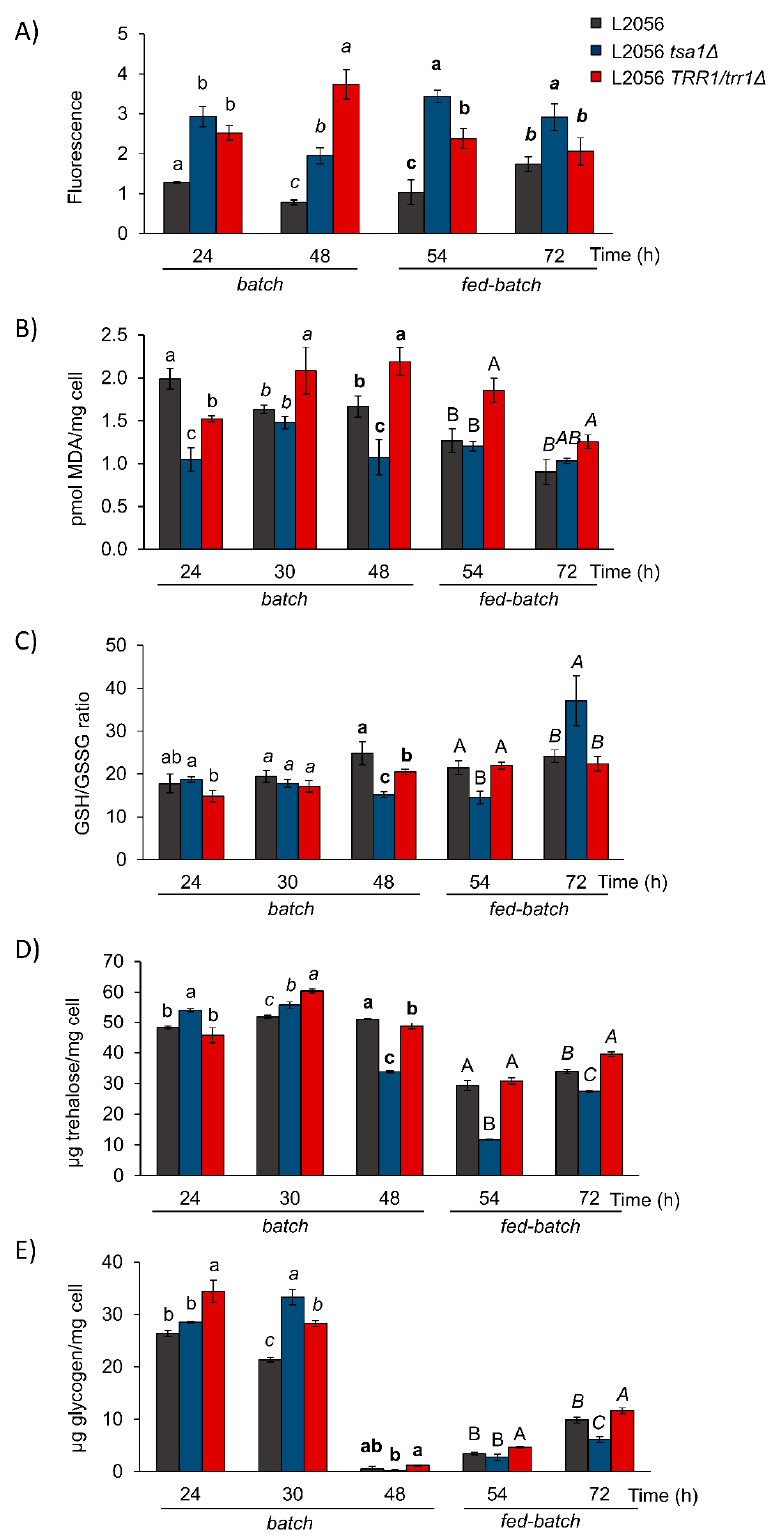
Figure 5. Oxidative stress parameters during growth in fermenters. L2056, the L2056 tsa1 ∆ mutant and L2056 trr1 ∆ / TRR1 were grown as described in Figure 4. ( A ) ROS. DHE fluorescence is indicated. ( B ) Lipid peroxidation. ( C ) Glutathione GSH / GSSG ratio. ( D ) Trehalose. ( E ) Glycogen. Experiments were carried out in triplicate. The mean and standard deviation are shown. Means with the same letter are not significantly di ff erent ( p < 0.05) at the same times according to Tukey’s test. Di ff erent font styles enable comparing the same strain in di ff erent